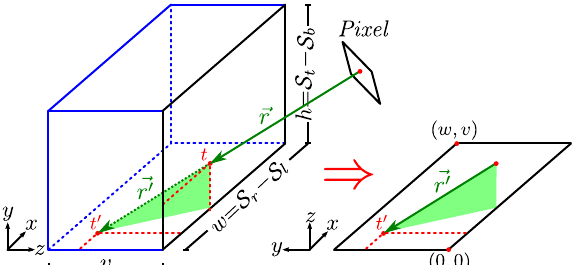
Figure 9: By tracing along the viewing ray that hits the current scope at the texture coordinates t we determine the hit face of a box that lies behind the scope. This yields a new scope, e.g. S = (0 , 0 , w, v ) for the bottom face where w = S r −S l and v is the intrusion amount. The texture coordinates t (cid:48) are now defined with respect to the new scope. This enables us to further evaluate the grammar on any face within the box as